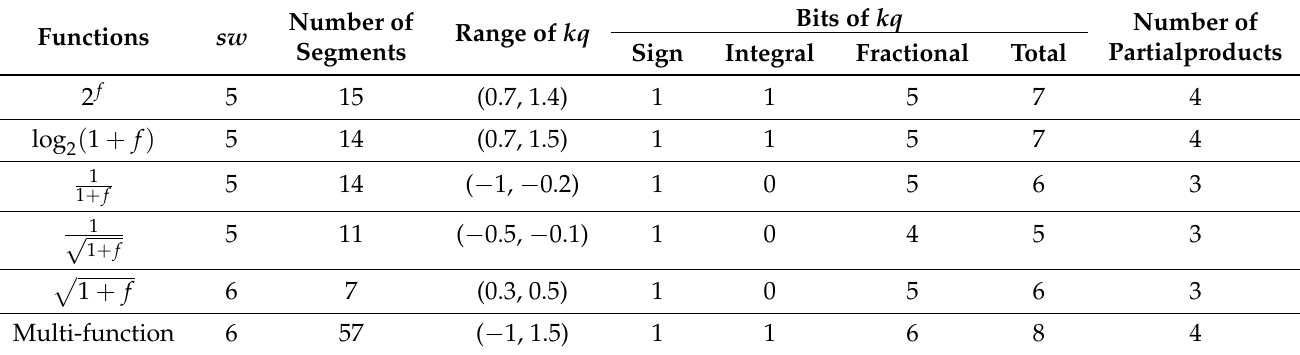
Table 1. Selected values of sw in our proposed architecture and corresponding parameters.